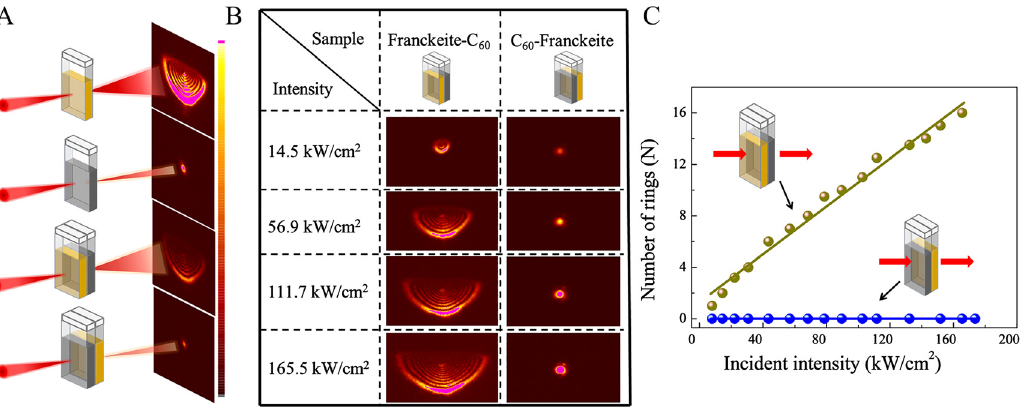
Figure 6: The experimental results obtained from the franckeite/C 60 -based nonlinear photonic diode, and the phenomenon of unidirectional diffraction rings